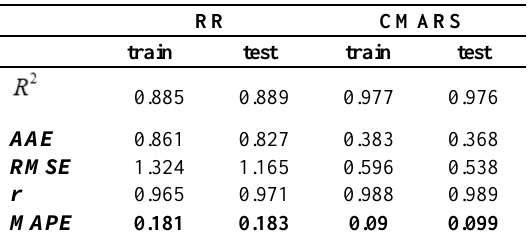
Table 3. Performance of RR and CMARS for one-week ahead